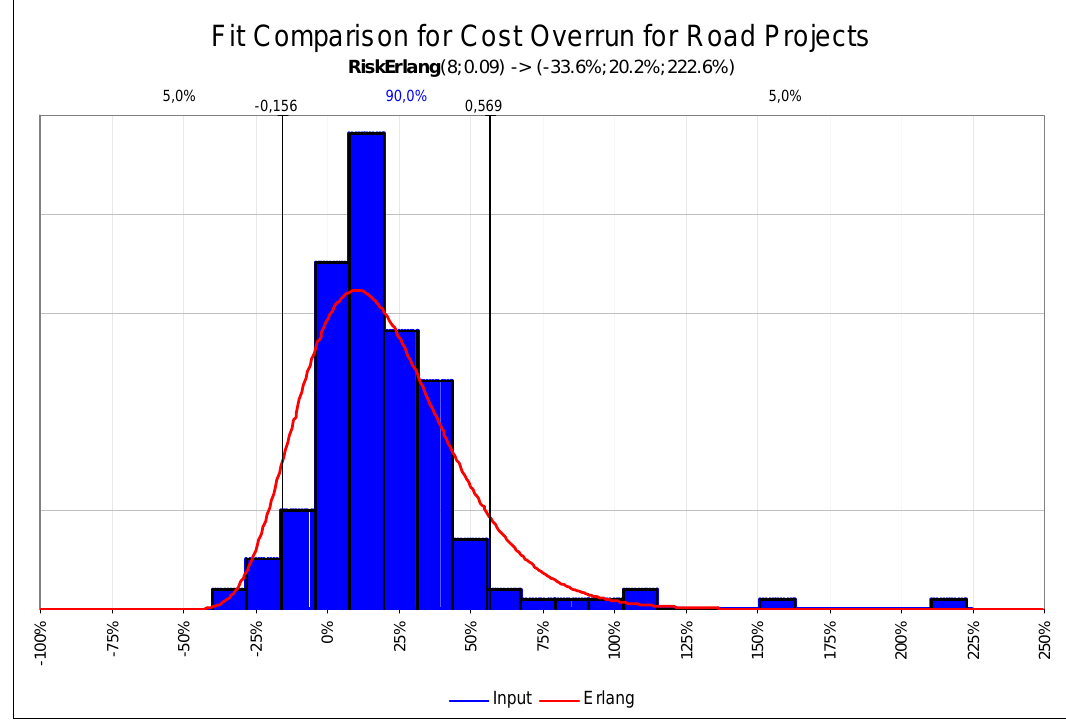
Figure 4. Inaccuracies of construction cost estimates of 167 infrastructure projects (from Flyvbjerg et al. (2003), p.